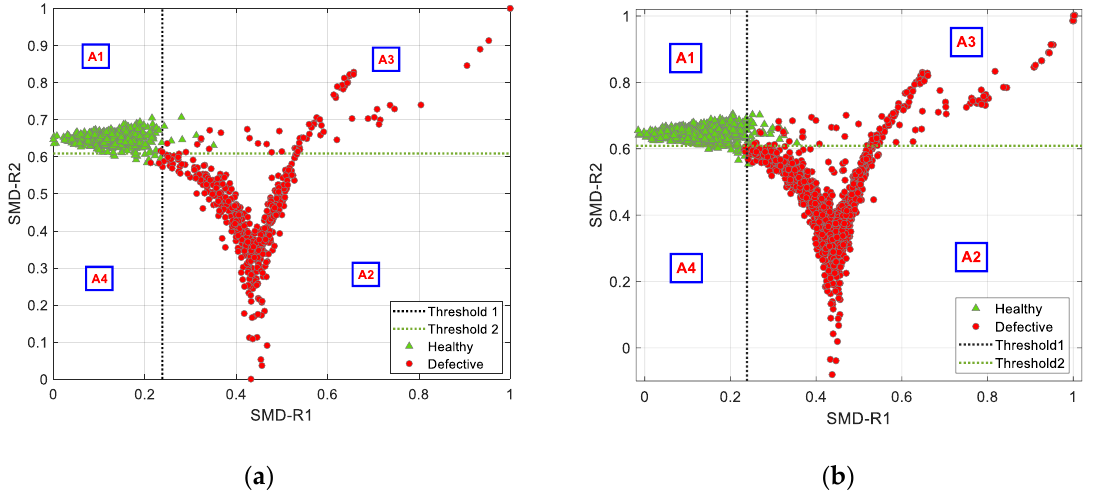
Figure 13. ( a ) Classification on the training dataset; ( b ) classification on the testing dataset.